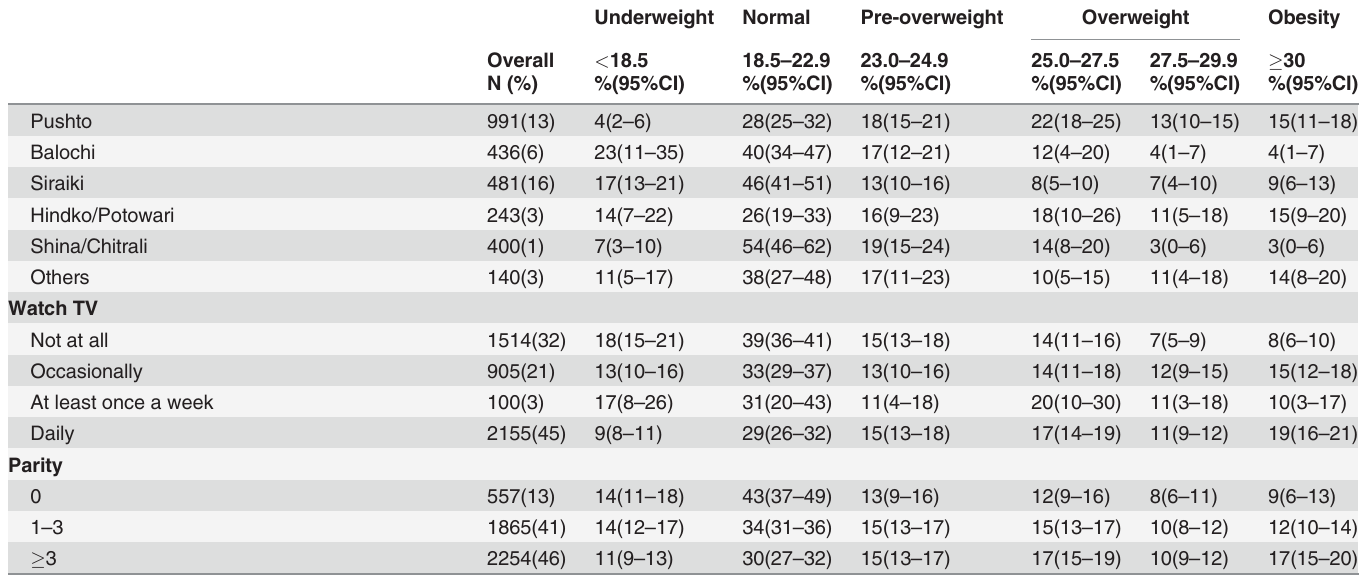
Household SEP and overweight categories There was an increase in pre-overweight, overweight and obesity with increasing HWQs (Table 1, S1 Fig and S1 Table). The Multivariable model showed a graded increase in adjusted odds ratios (aOR) for overweight and obesity with increasing HWQs. For those in 5 th quintile Community wealth, residence area and under- and